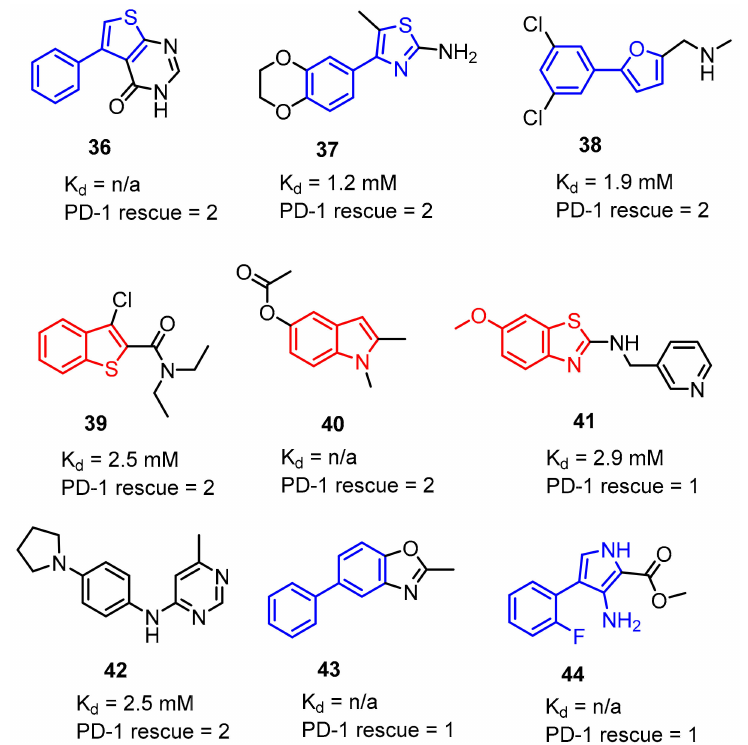
Figure 18. Examples of hits 36 – 44 found in the fragment-based screening published by Perry et al. [44]. Fragments were able to displace PD-1 from PD-L1 in the NMR-based AIDA assay [66]. The PD-1 rescue score was estimated on the percent of the G90 signal rescued of the 15 N labeled PD-1 at 800 µ M fragment concentration. Score 1 indicates 1–15% signal rescue and score 2 indicates > 15% signal rescue (some of the K d values were not determined due to solubility limits and / or resonance peak broadening).